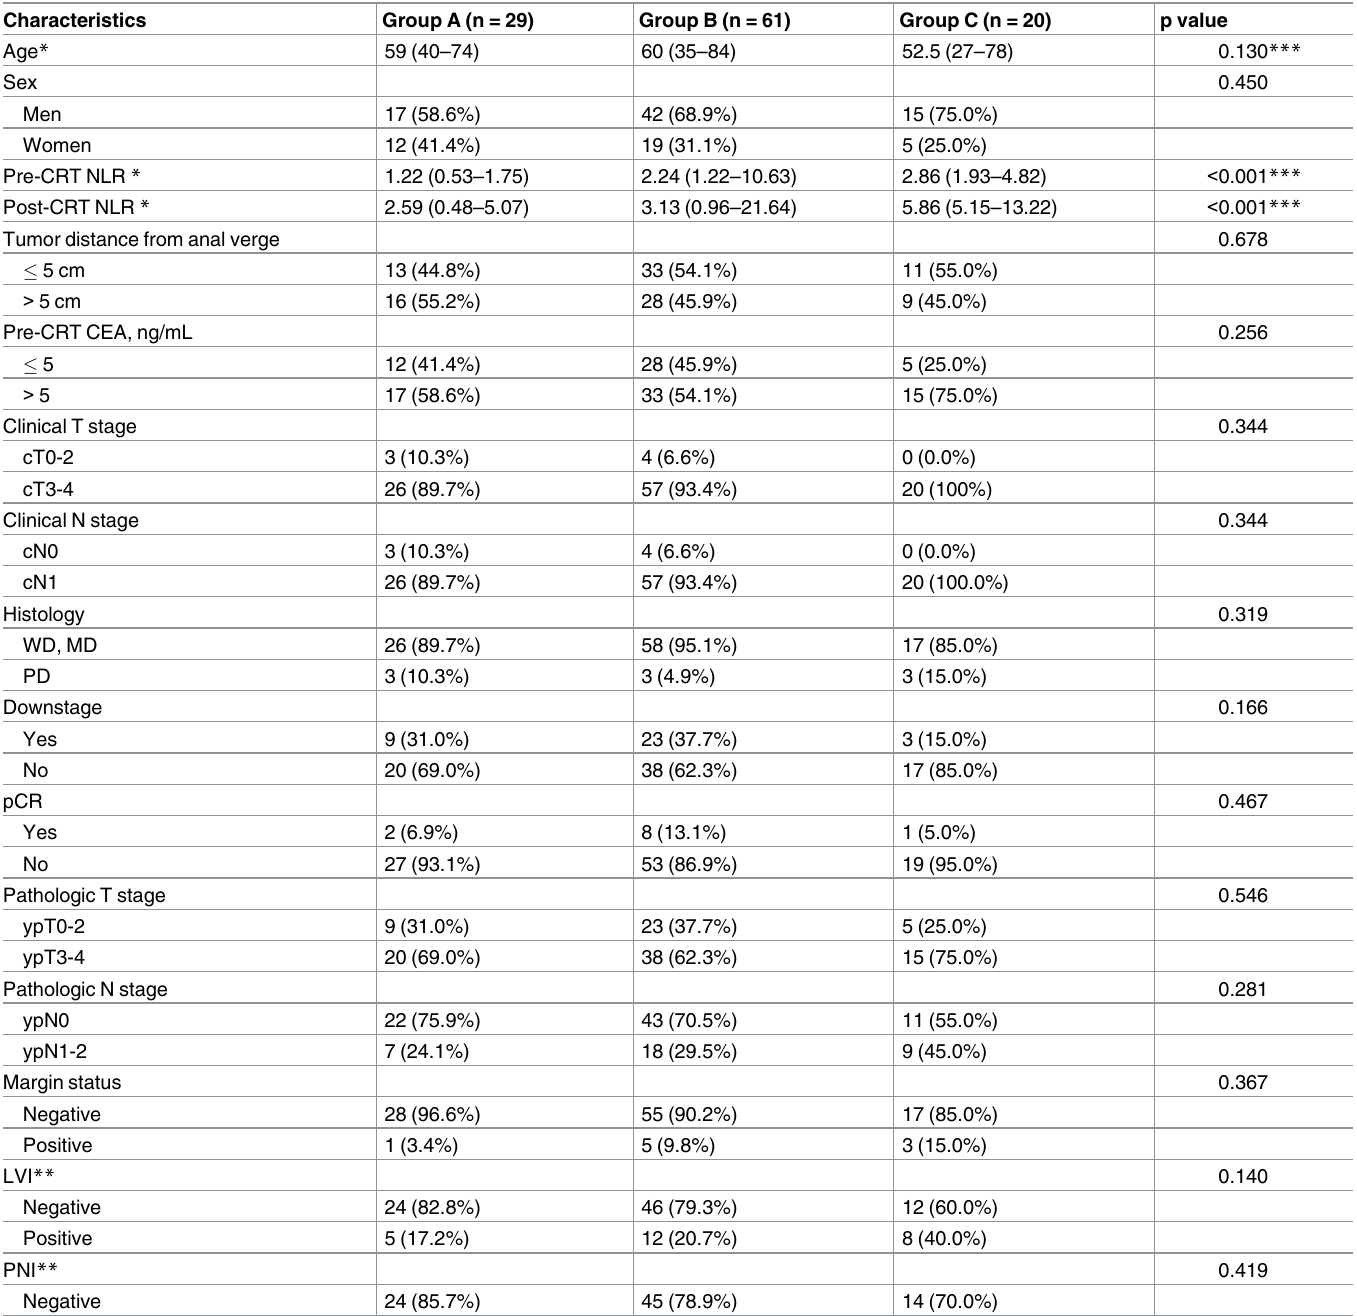
Table 2. Patients characteristics according to NLR